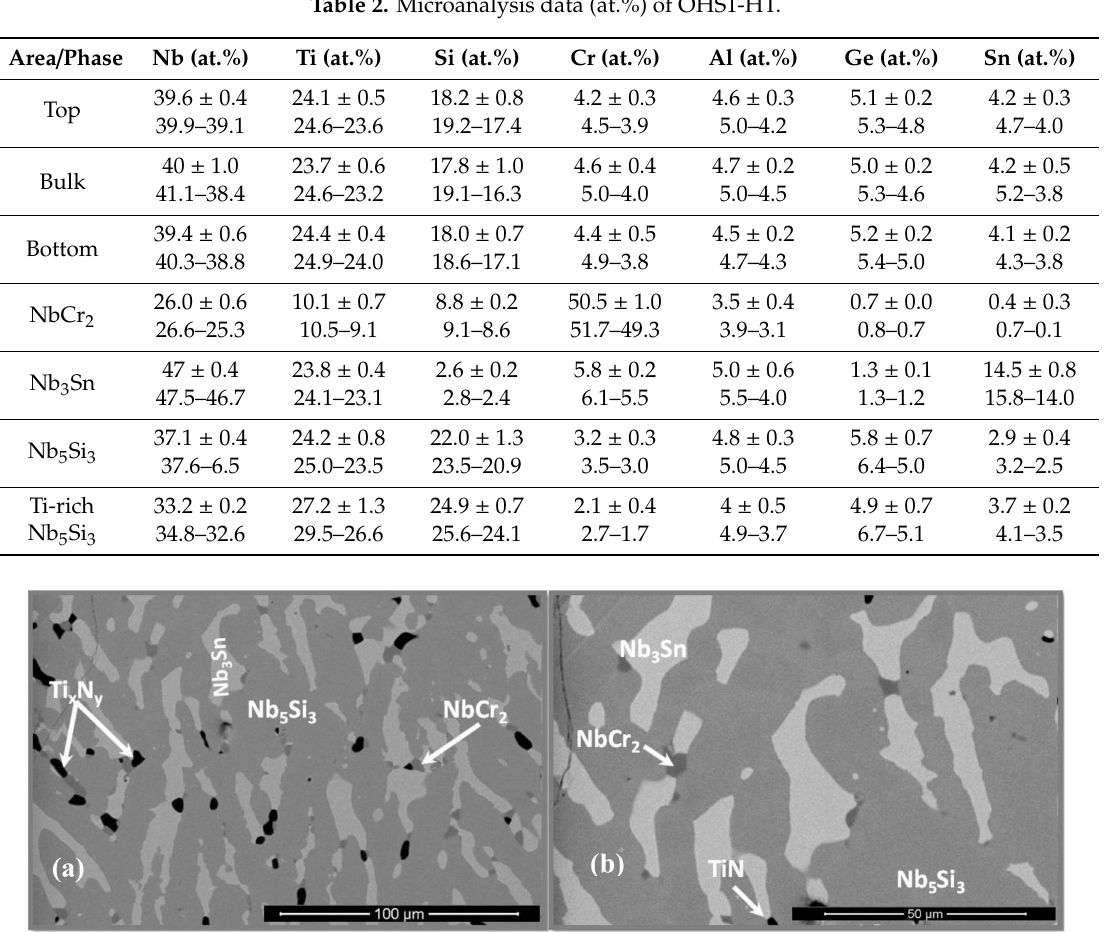
Figure 3. BSE images of the microstructure of OHS1-HT: ( a ) bulk and ( b )